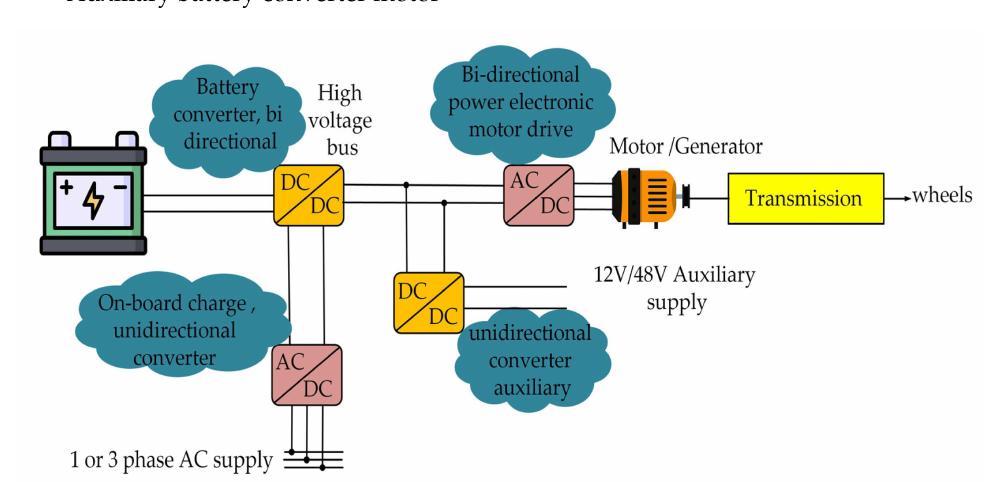
Figure 7. Block diagram of main converters of EVs.